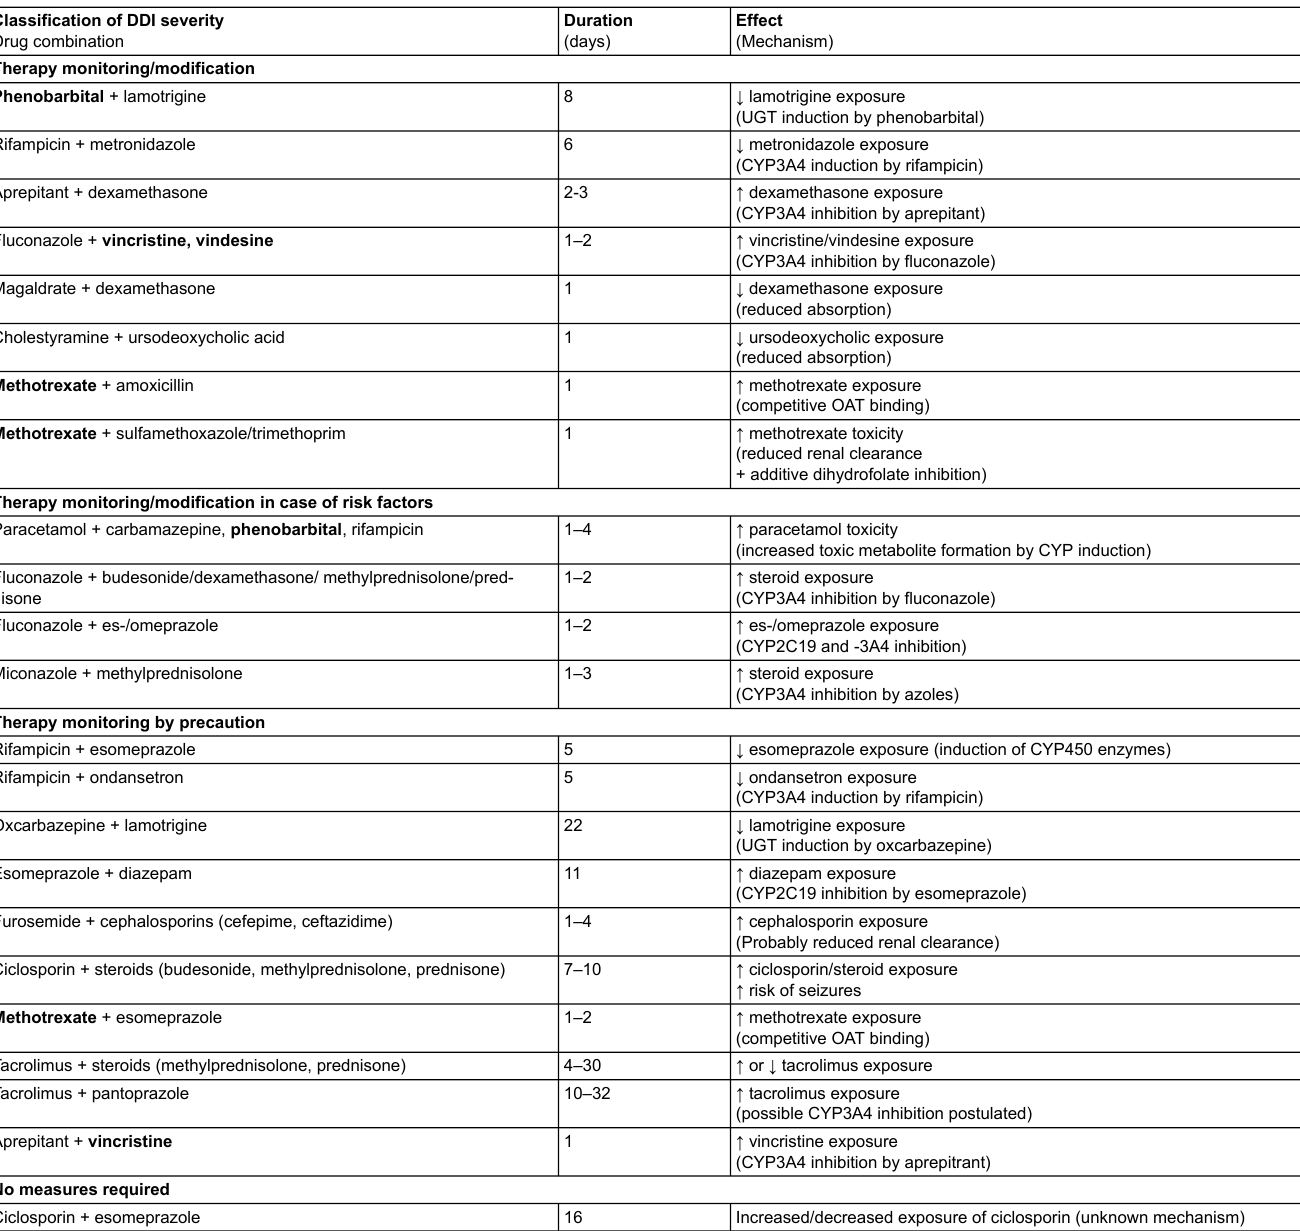
Table 3: Summary of other pharmacokinetic drug-drug interactions (DDIs) issued (not rated as “contraindicated” or “contraindicated by precaution”). Classification of DDI severity Drug combination